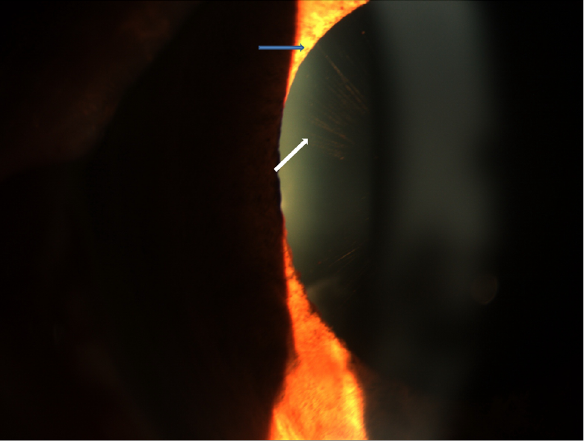
Figure 3. Slit lamp photograph showing radial pigmentary pattern of deposits on the anterior lens surface (white arrow) with adjacent pupillary ruff atrophy (blue